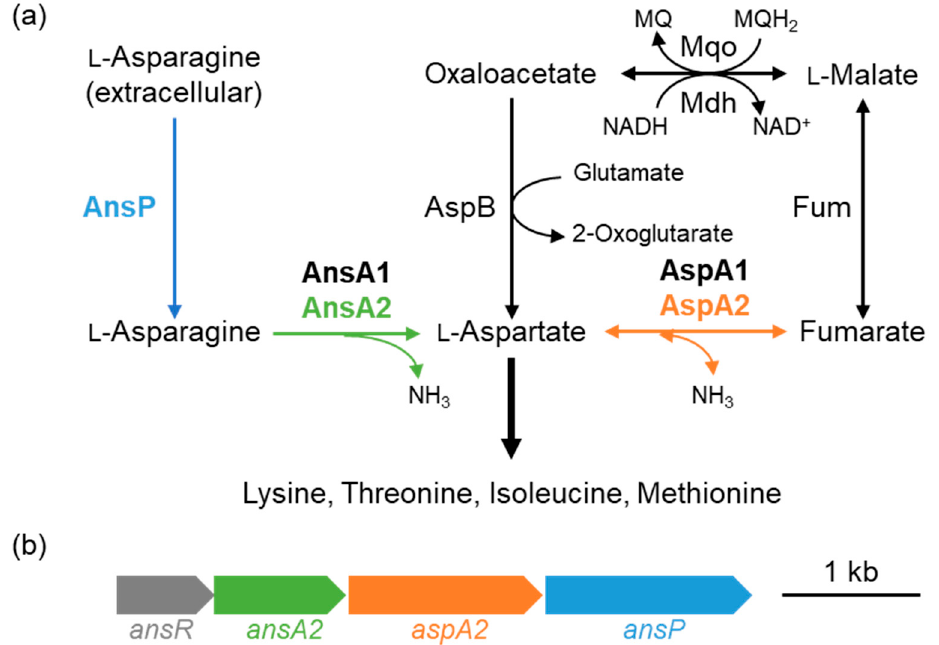
Figure 1. ( a ) Metabolic pathway of L-asparagine and L-aspartate in Corynebacterium glutamicum strain R. Proteins encoded by the ans gene cluster ( b ) are shown in the corresponding colors. AnsA1 and AnsA2: asparaginase; AspA1 and AspA2: aspartase; Fum: fumarase; AspB: L-aspartate aminotransferase; Mqo: malate:quinone oxidoreductase; Mdh: malate dehydrogenase; MQ: menaquinone; and MQH 2 : menaquinol. ( b ) The ans gene cluster.